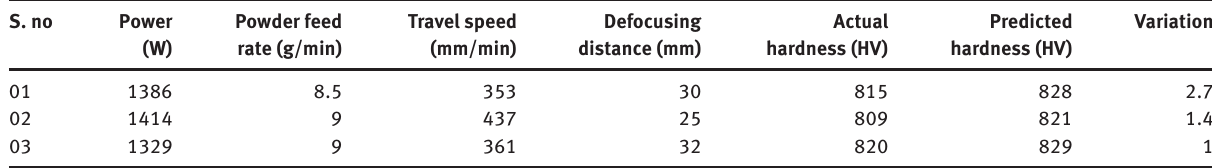
Table 9: Validation test results for optimization procedure. S.